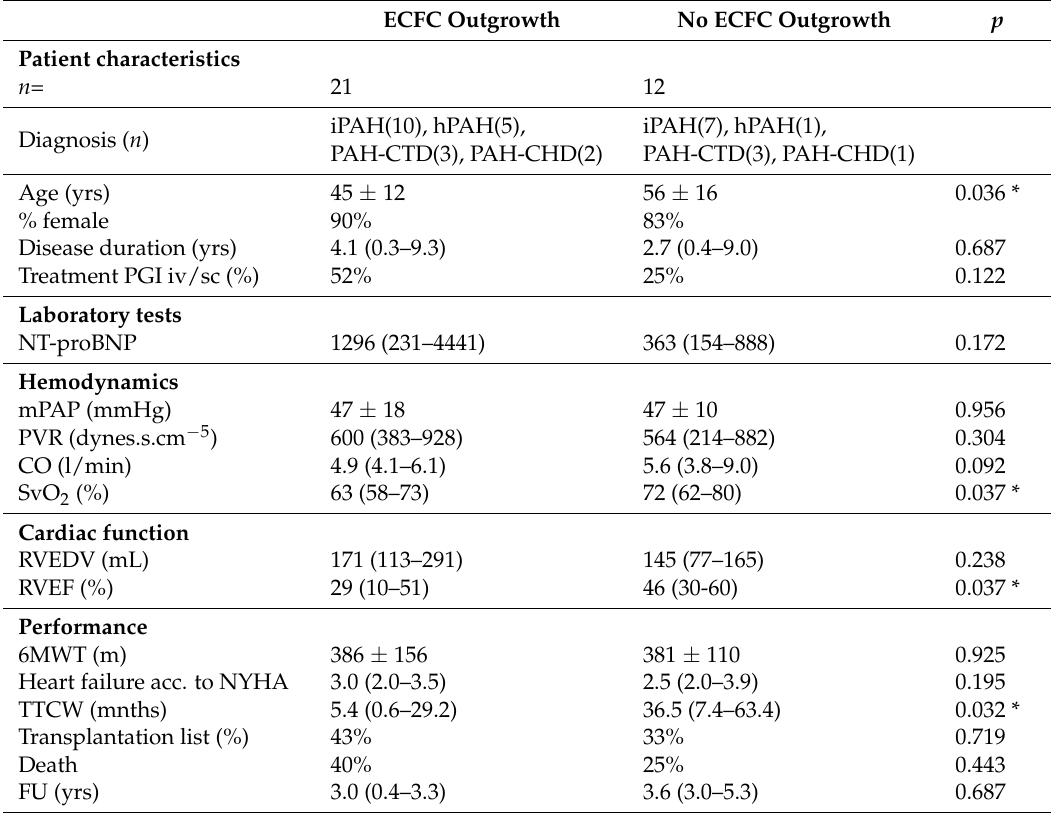
Table 1. Clinical characteristics of PAH patients with and without outgrowth of